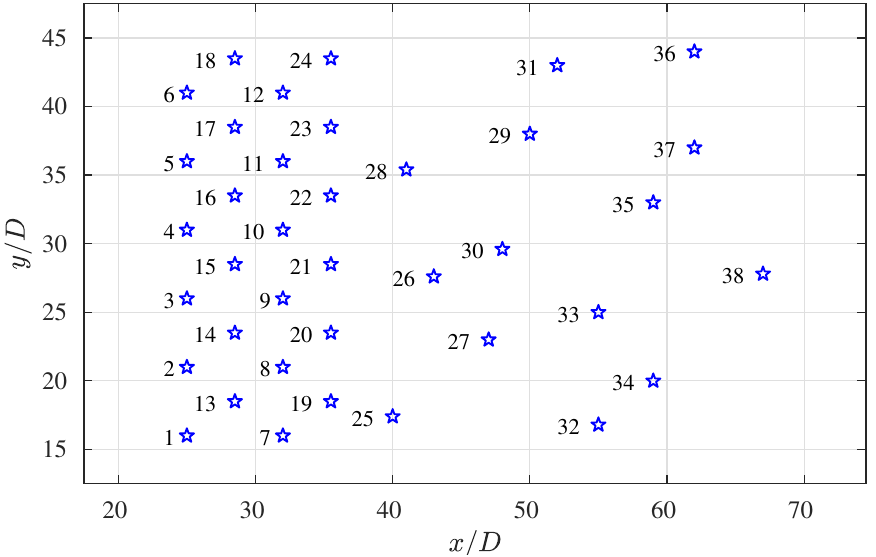
Figure 7. Locations of the 38 turbines in the wind farm simulated in